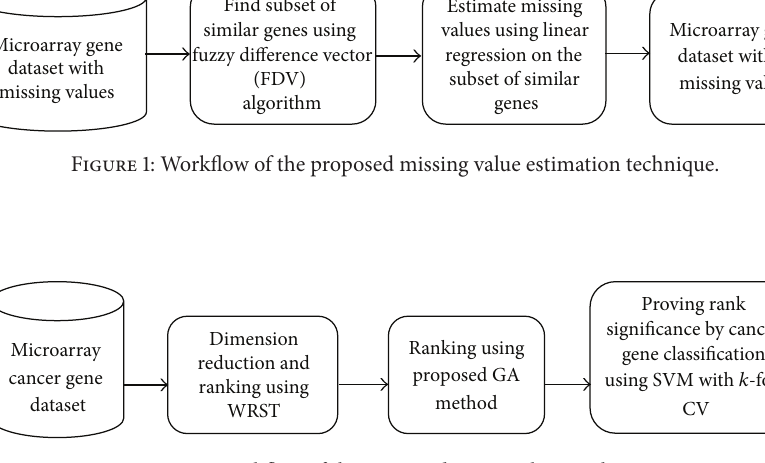
Figure 2: Workflow of the proposed gene ranking